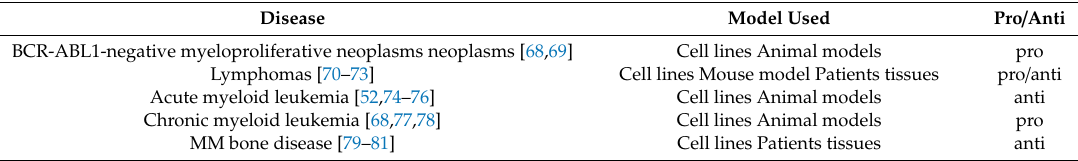
Table 1. Pro / antitumorigenic role of IL-33 in hematological